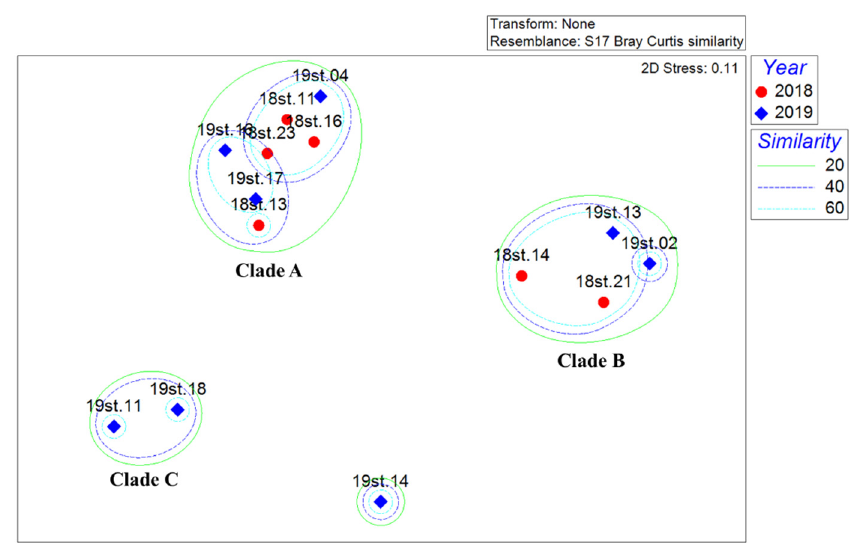
Figure 4. A non-metric multidimensional scaling (NMDS) plot of 14 zooplankton communities based on Bray–Curtis similarity matrix, calculated with the proportions of each species or taxon in the community. Symbols indicate the different sampling years (red circle for 2018; blue diamond for 2019). Green, blue, and light-blue lines represent similarity between the communities of 20%, 40%, and 60%, respectively.